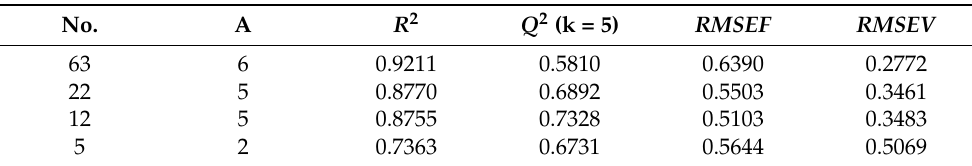
Table 1. The values of the R 2 , Q 2 , RMSEF, and RMSEV for the 2D-QSAR model for catalytic activity at different numbers of